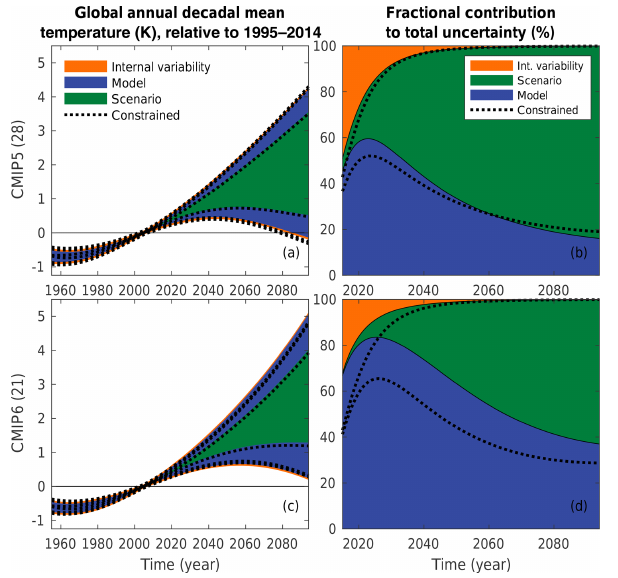
Figure 9. (a) Sources of uncertainty in the multimodel multi- scenario mean projection of global annual decadal mean temper- ature in CMIP5. (b) Fractional contribution of individual sources to total uncertainty. Observationally constrained projections are given by the dotted lines (see text for details). (c, d) Same as (a) and (b) but for